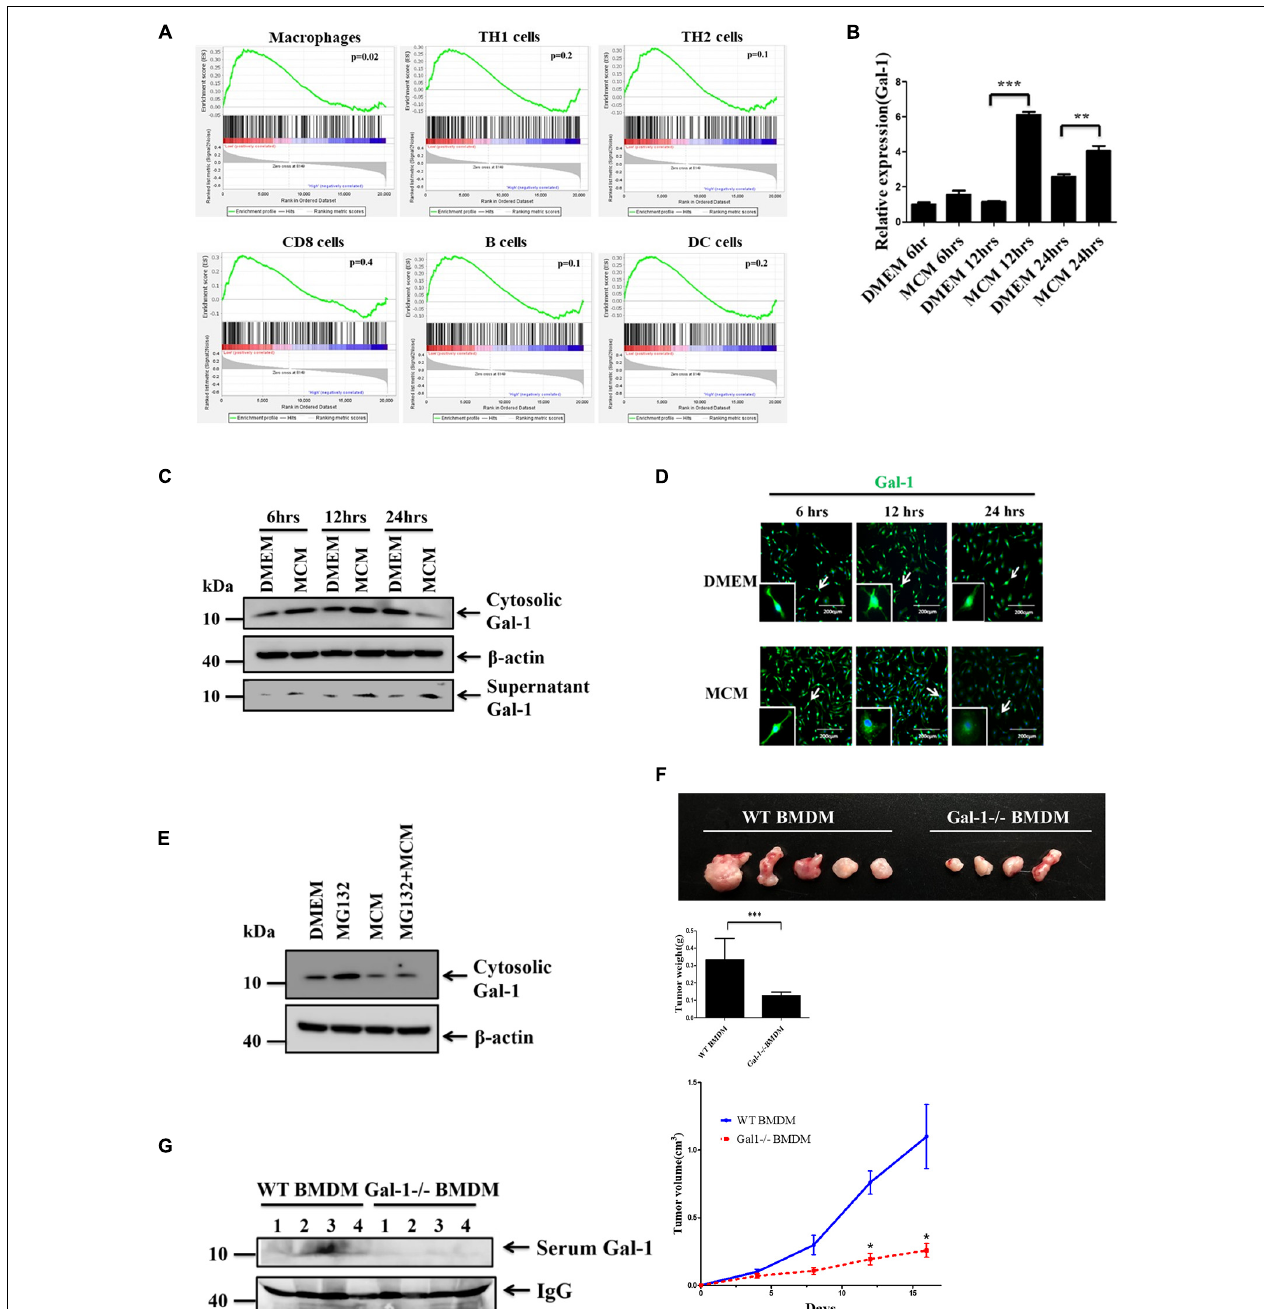
FIGURE 1 | HCC cells stimulate macrophages to actively secrete Gal-1. (A) GSEA of Gal-1 mRNA expression in HCC-associated immune cells. The data of Gal-1 mRNA expression in human liver cancer patients was obtained from the cancer genome atlas (TCGA) database. Enrichment scores (ES) are shown on the y-axis. X-axis bars represent individual genes of immunologic signature gene sets. Color bars represent the expression level of Gal-1. Positive and negative ES indicate enrichment of immunologic signature gene sets in high expression galectin-1 and low expression galectin-1, respectively. (B–D) BMDMs were treated with MCM at indicated time. The expression levels of Gal-1 mRNA were determined by qRT-PCR and quantified (B) . The expression of cytosolic Gal-1, β -actin as well as supernatant Gal-1 proteins was determined by Western blotting (C) or immunofluorescence staining (D) . All blots were derived from a single experiment. (E) BMDMs were pretreated with or without MG132 (0.25 µ M) for 1 h prior to adding MCM. The expression of cytosolic Gal-1 and β -actin was determined by Western blotting. All blots were derived from a single experiment. (F,G) 5 × 10 5 ML-1 4 a cells mixed with 5 × 10 5 WT or Gal-1 -/- BMDMs were subcutaneously inoculated into nude mice ( n = 5). Tumor volume was measured every 4 days after inoculation. All mice were sacrificed on day 16. The representative images of HCC tumors were shown, and the tumor weights were quantified (F) . The expression of galectin-1 in mice serum was measured by Western blotting (G) . All blots were derived from a single experiment. * p < 0.01; ** p < 0.001; *** p < 0.0001.